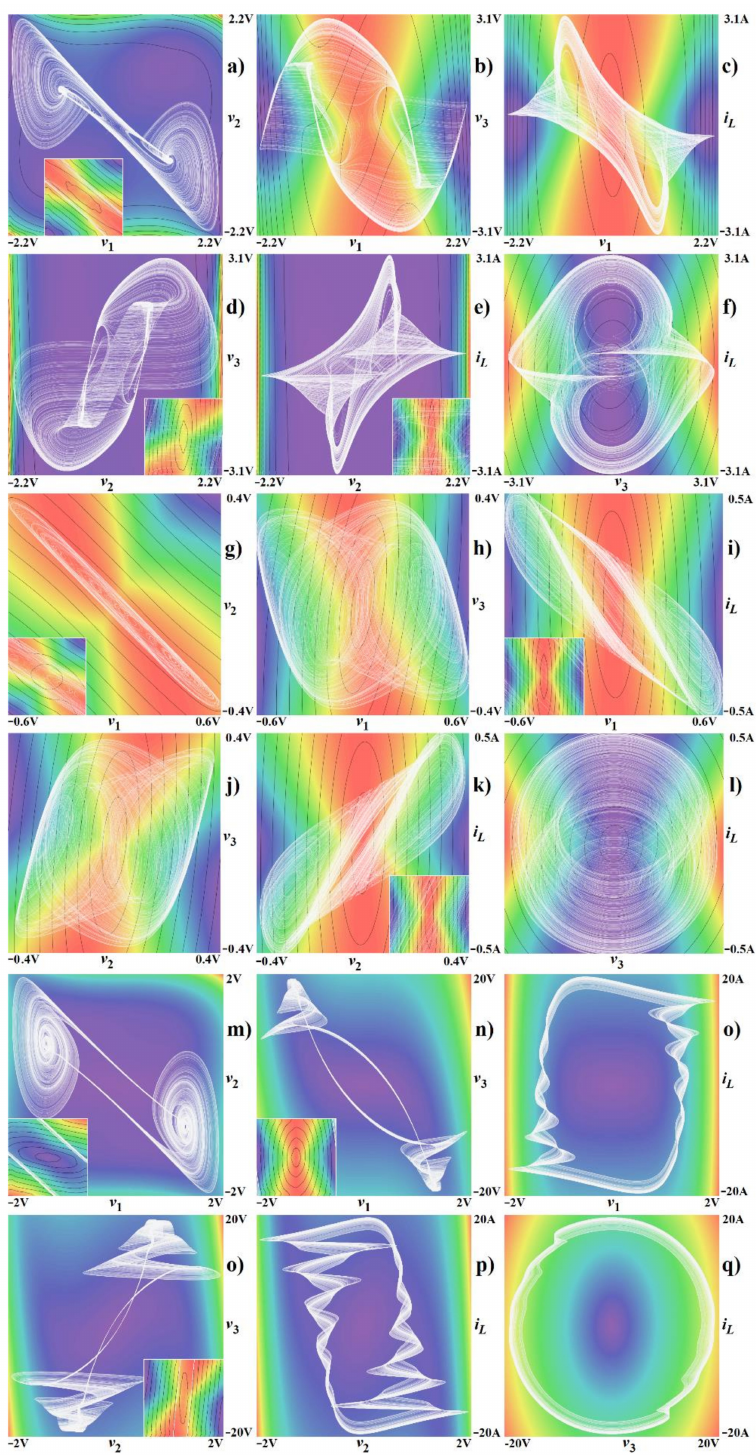
Figure 4. Cascoded resonant amplifier considered as a fourth order autonomous dynamical system. Kinetic energy distribution over the state space visualized in all available plane projections and for: ( a – f ) parameter set b = 9.02 S, b = 3.76 S, ( g – l ) b = 4.75 S, b = 0.98 S, and ( m – q ) b = 0.6 S, b = 4.31 S. In each plot, only two state variables are swept while remaining state variables are kept zero. See text for the better understanding of the individual plots.